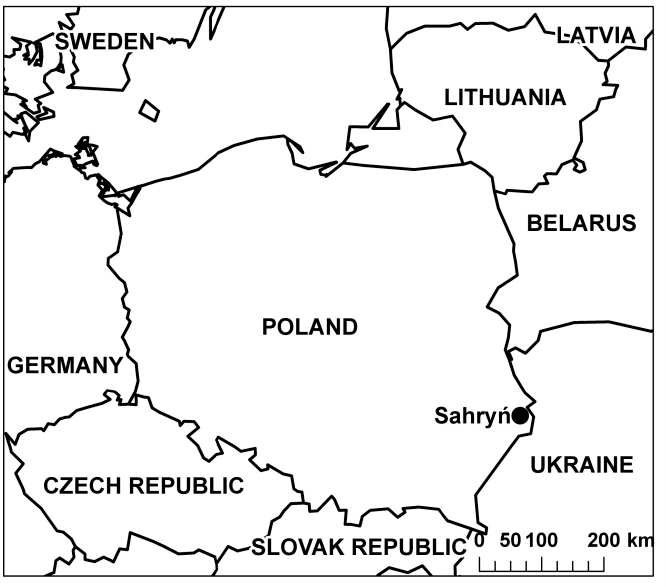
Figure 1. Location of the field experiment.